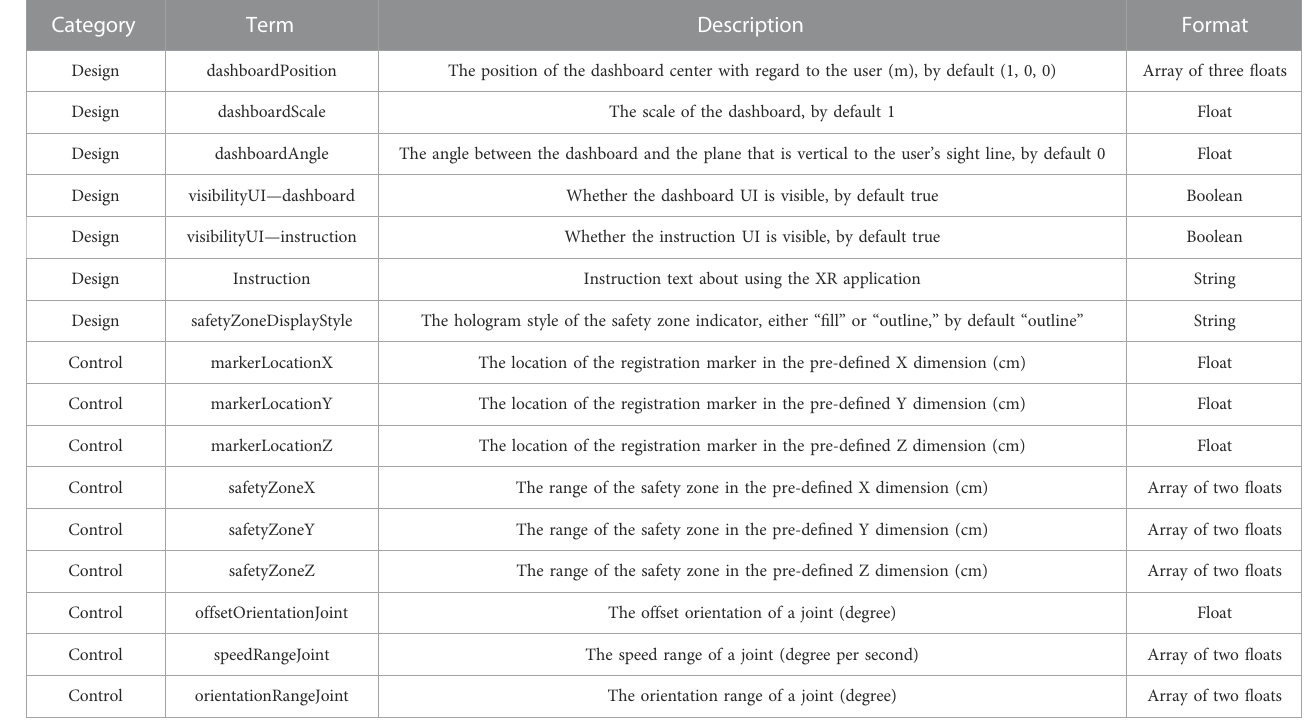
TABLE 2 Descriptions of terms for XR ontology in the robot arm DT documents.